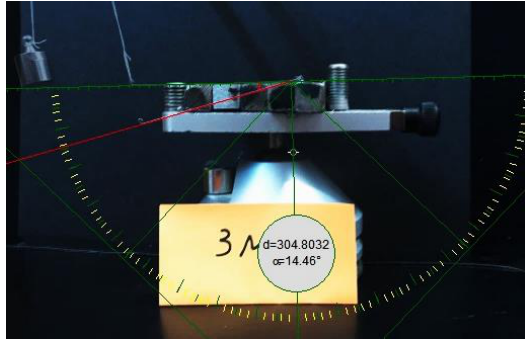
Figure 5: The two photographs after being edited in Adobe Photoshop and the angle measured by MB-